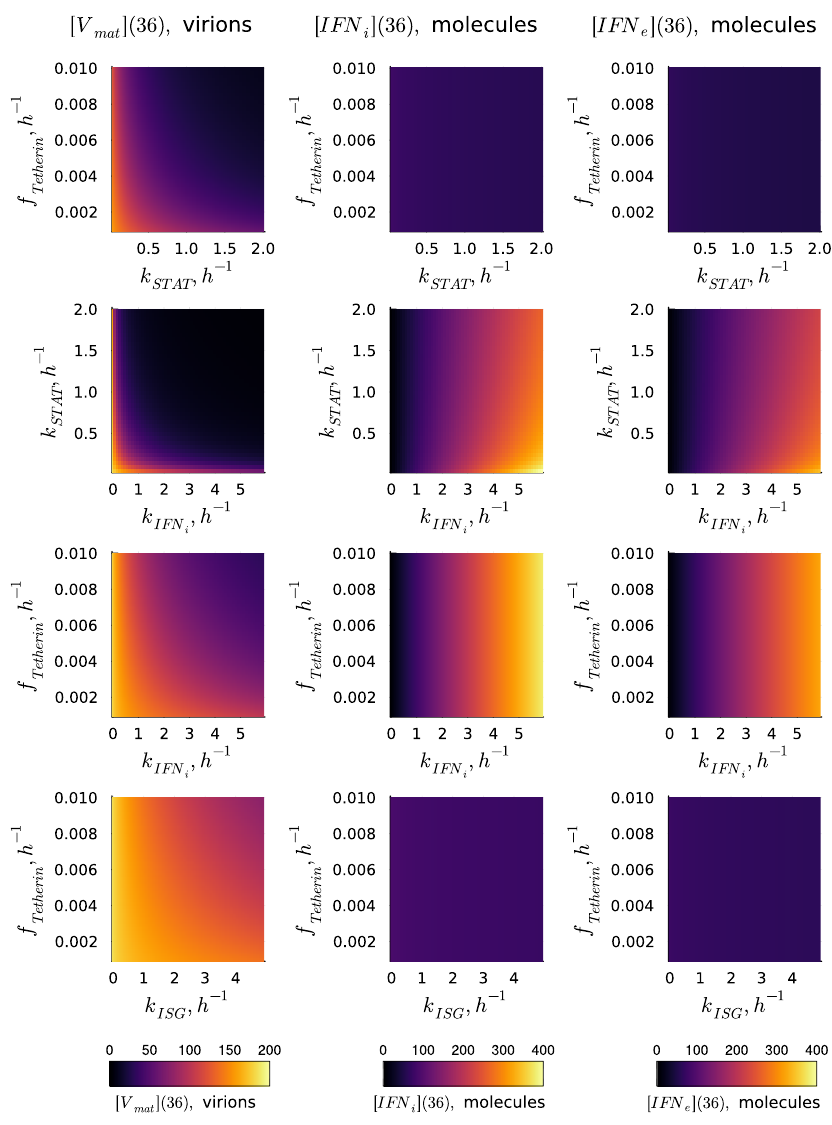
Figure 3. Effectiveness of various processes underlying IFN-mediated suppression of virus replication in a cell in the absence of IFN from other cells, i.e., the autocrine mode of control. Results of the sensitivity analysis of the deterministic model solution ( [ V mat ]( 36 ) , [ IFNi ]( 36 ) , and [ IFN e ]( 36 ) ) with respect to variations in the parameters f Tetherin , k STAT , k IFNi , and k ISG . The results correspond to the MOI of [ V free ]( 0 ) = 6 virions without extracellular IFN signalling: [ IFN e ]( 0 ) =